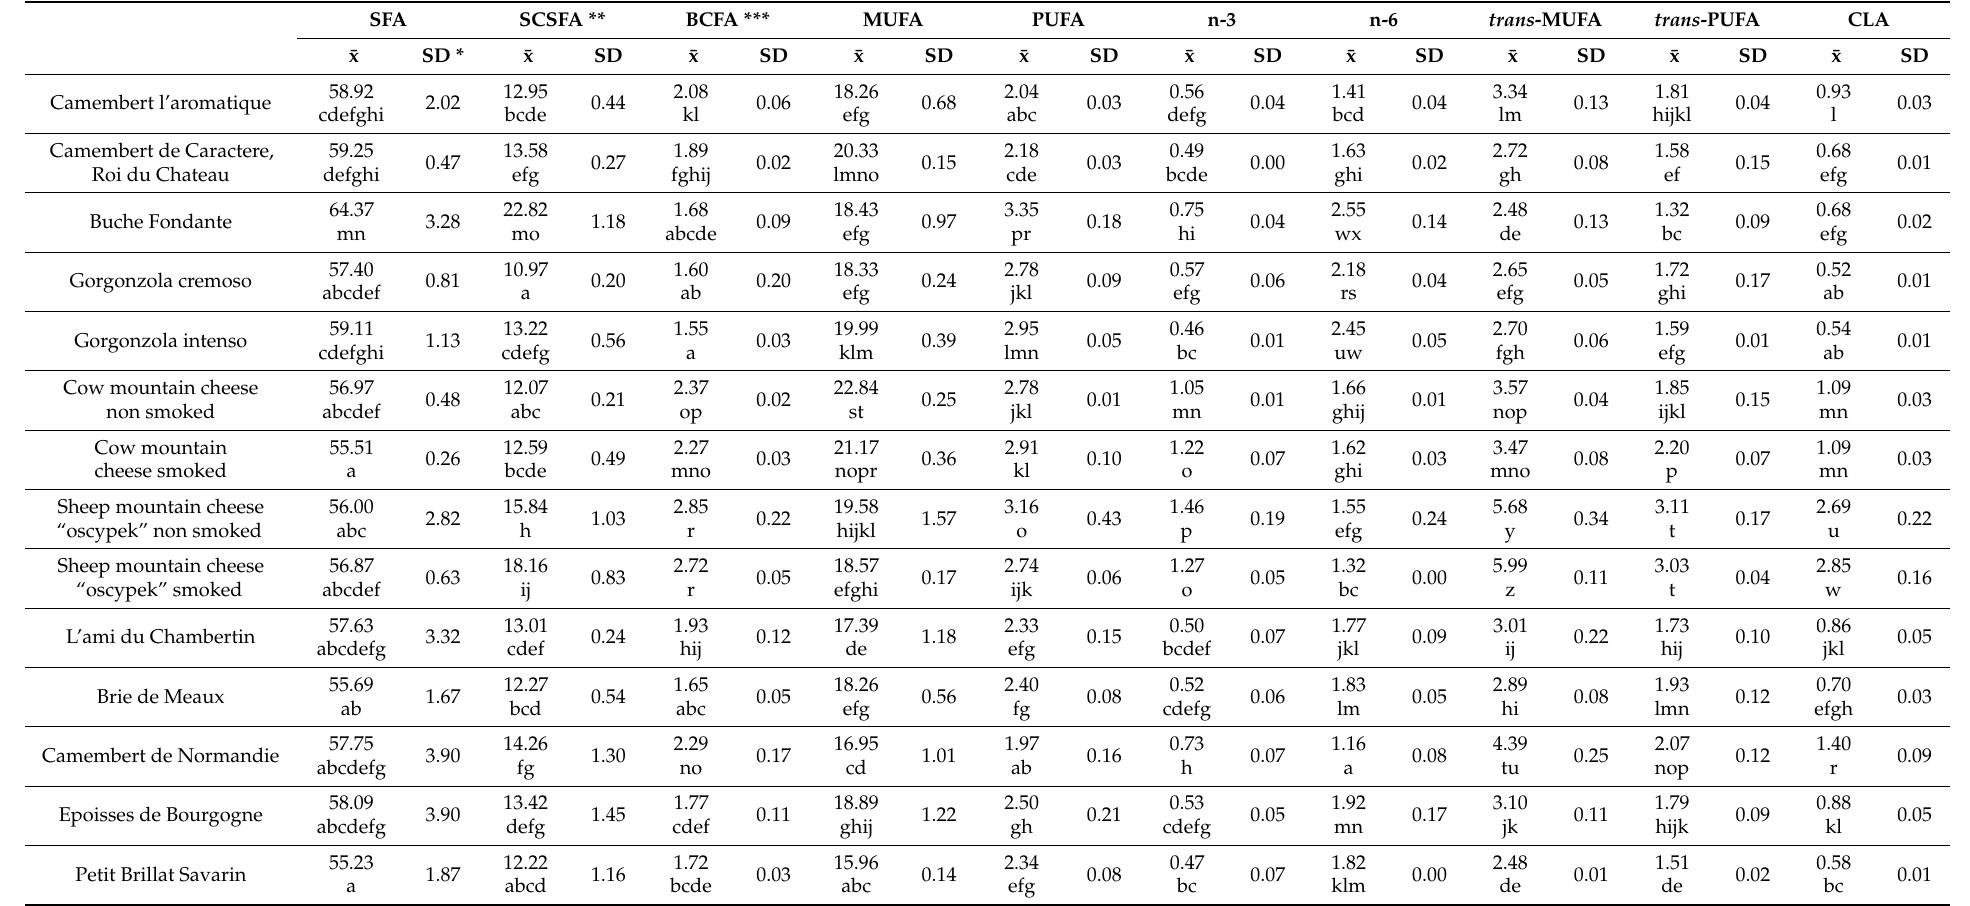
Table 2. Group of fatty acid content in commercial studied cheese samples [g 100 g − 1